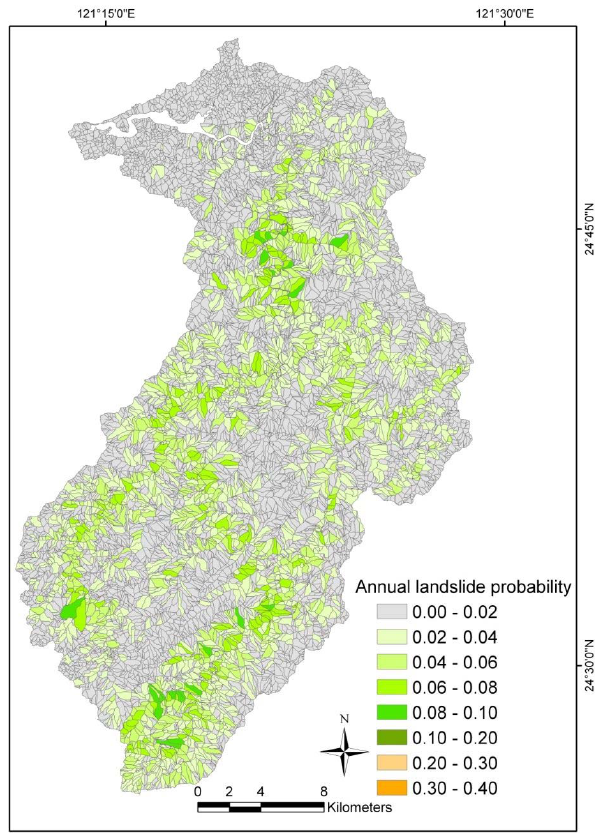
Fig. 13. Annual landslide probability for landslides with area ex- ceeding 3000m 2 in each slope unit. 4